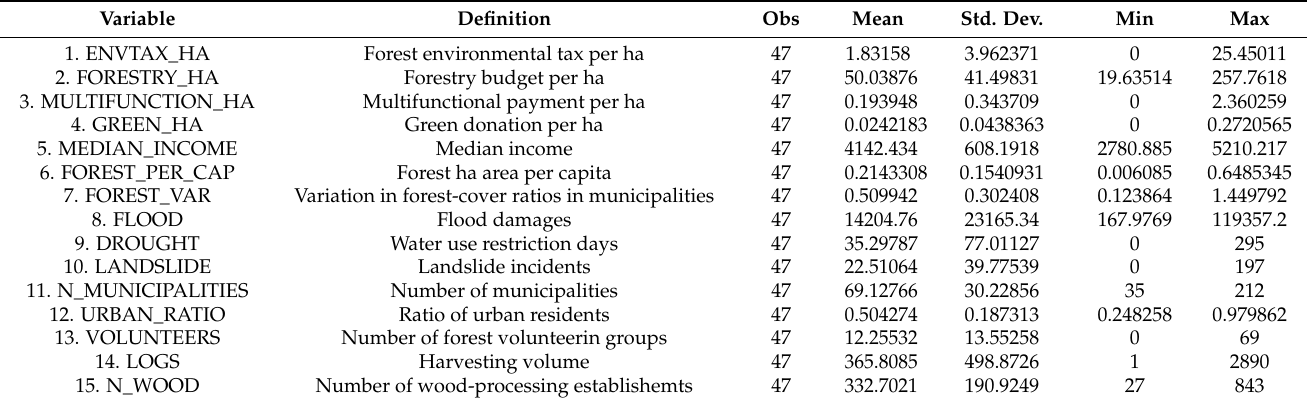
Table 1. The descriptive statistics of